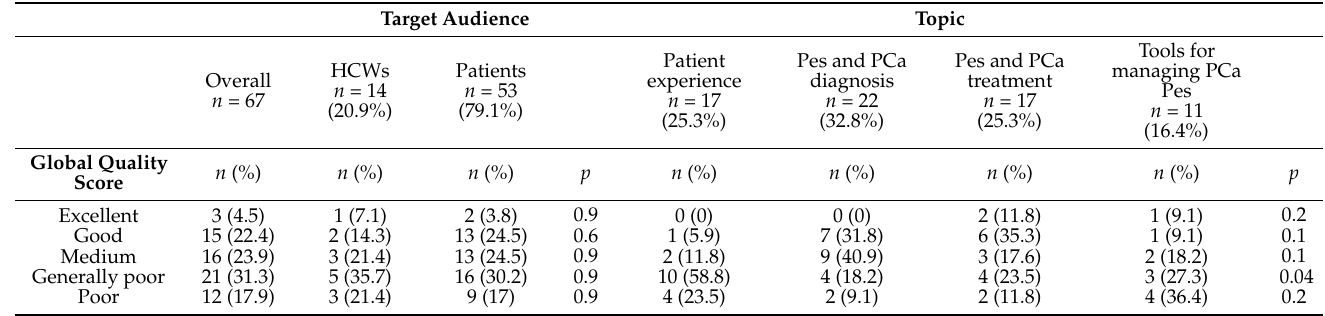
Table 3. Global Quality Score values of 67 YouTube videos on mental health of PCa patients stratified according to target audience (healthcare workers vs. patients) and topic (patient experience vs. psychological effects and PCa diagnosis vs. psychological effects and PCa treatment vs. tools for managing PCa psychological